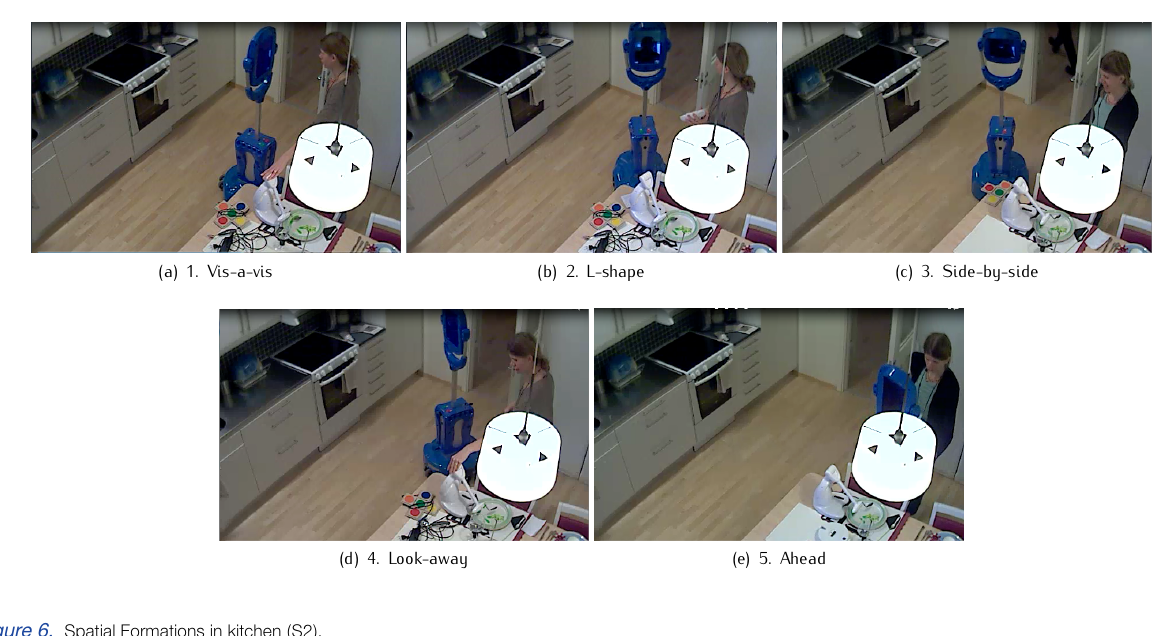
Figure 6. Spatial Formations in kitchen (S2).